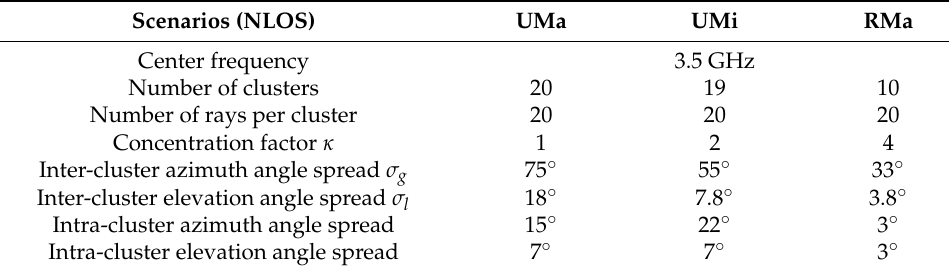
Table 2. Simulation parameters